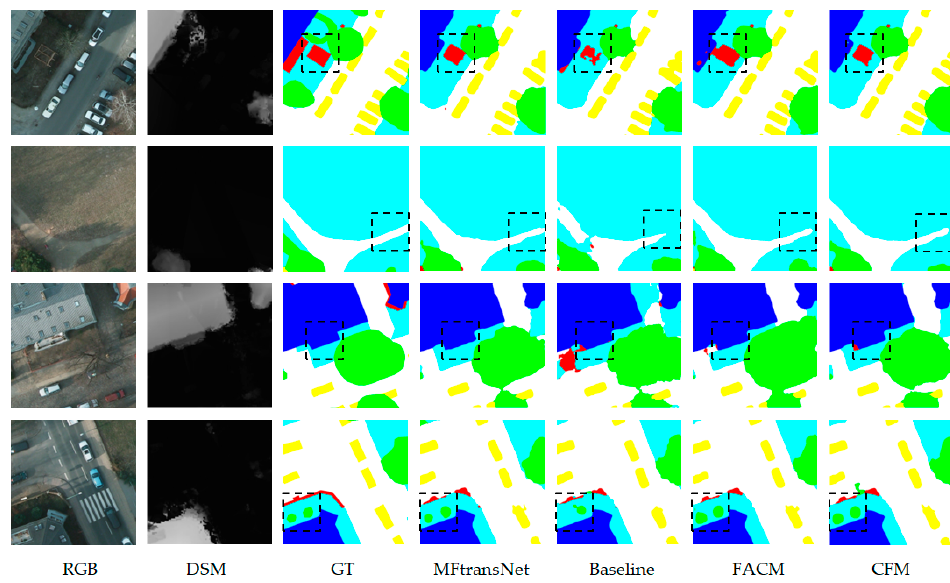
Figure 11. Visualization results of the ablation experiment.